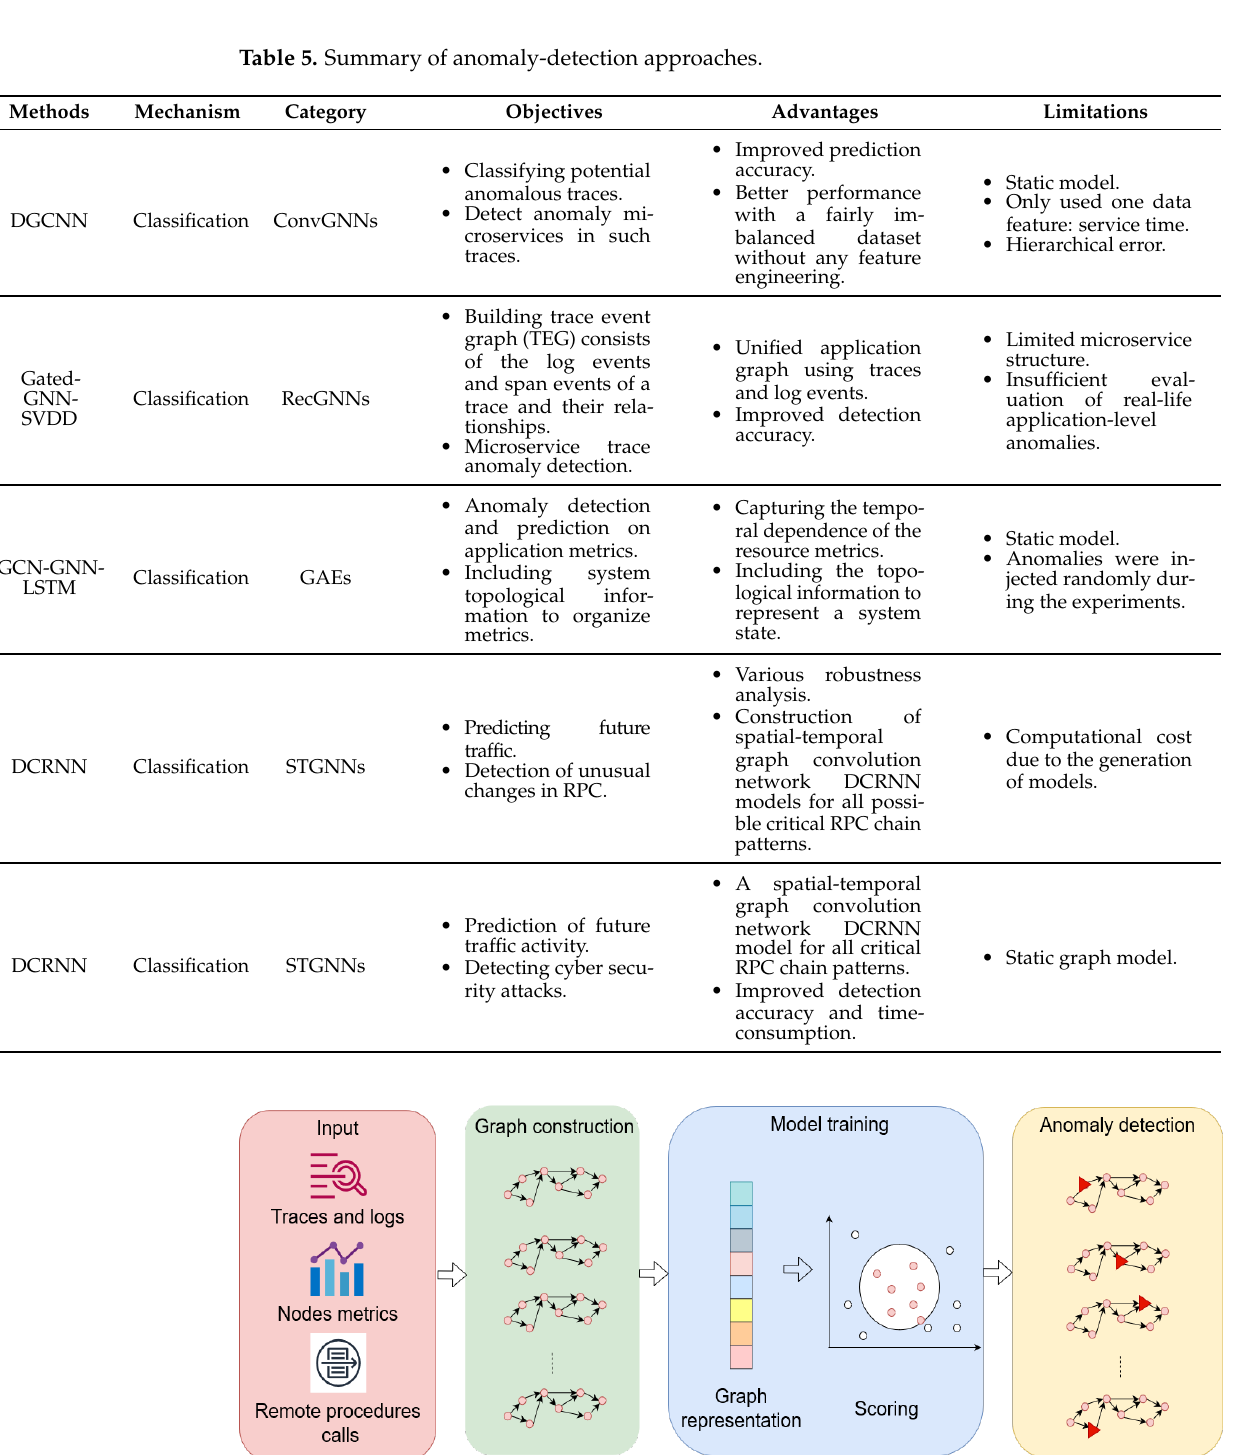
Figure 4. General procedure for an anomaly-detection algorithm using GNNs for